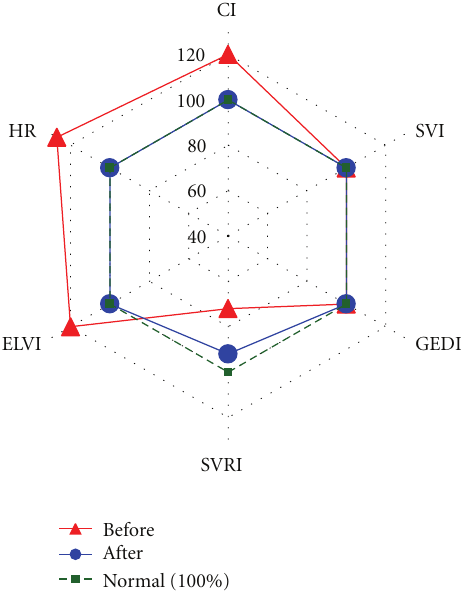
Figure 6: Hyperdynamic type of blood circulation in the patients of group STBI on the first day before and after correction. Note. Hemodynamic parameters are presented with percents from the normal